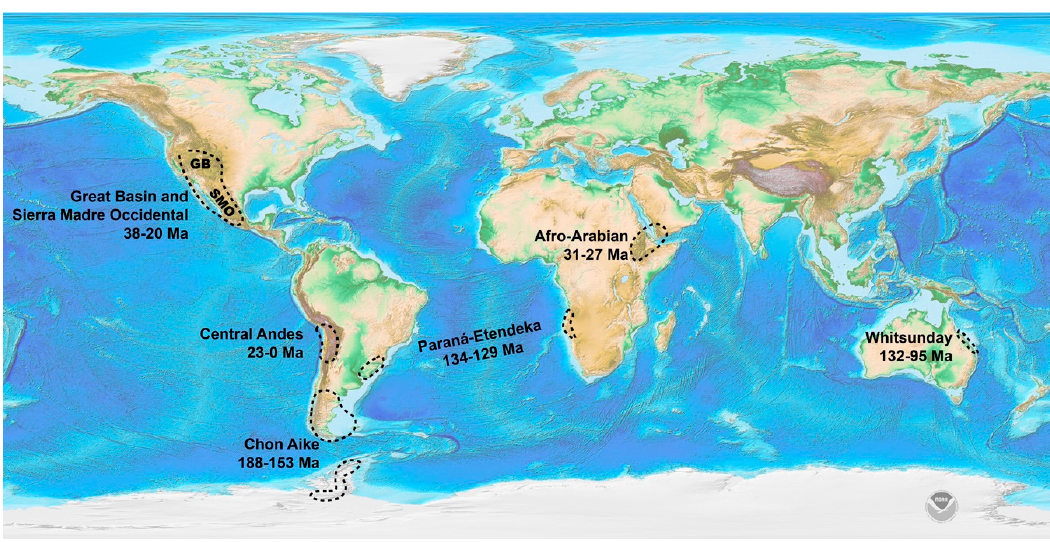
Figure 4. Locations of several large silicic ignimbrite provinces that formed in arid or plausibly arid environments, along with the three silicic large igneous provinces identified by Bryan [43]. All but the central Andean province formed during continental rifting, but most of these also formed in arid or hyperarid environments. Although there is a strong global correlation between magmatism and lithospheric extension, in detail extension may actually work to suppress growth of large magma bodies and caldera formation by opening fractures and promoting hydrothermal circulation.